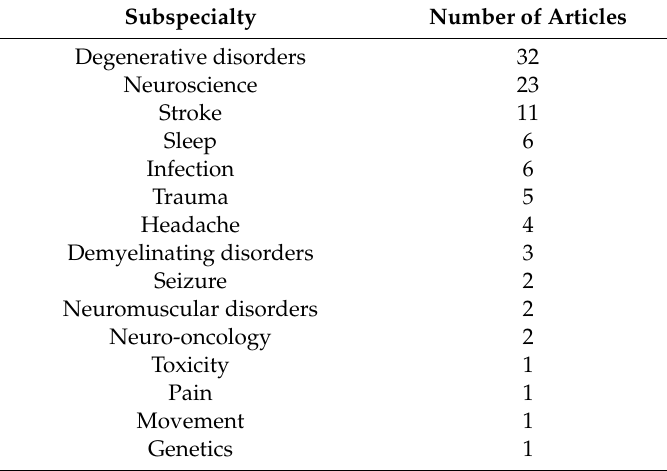
Table 4. Numbers of articles with top 100 AASs according to neurology subspecialties.